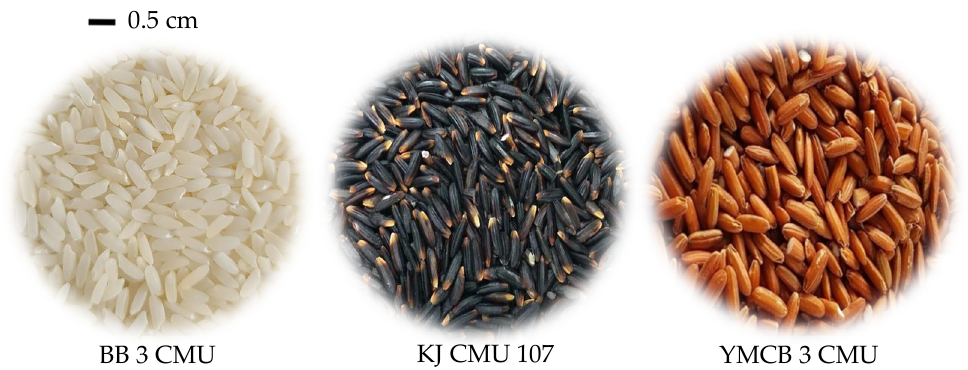
Figure 1. Characteristic rice kernels with non-pericarp color (BB 3 CMU), purple (KJ CMU 107) and red (YMCB 3 CMU) pericarp color.